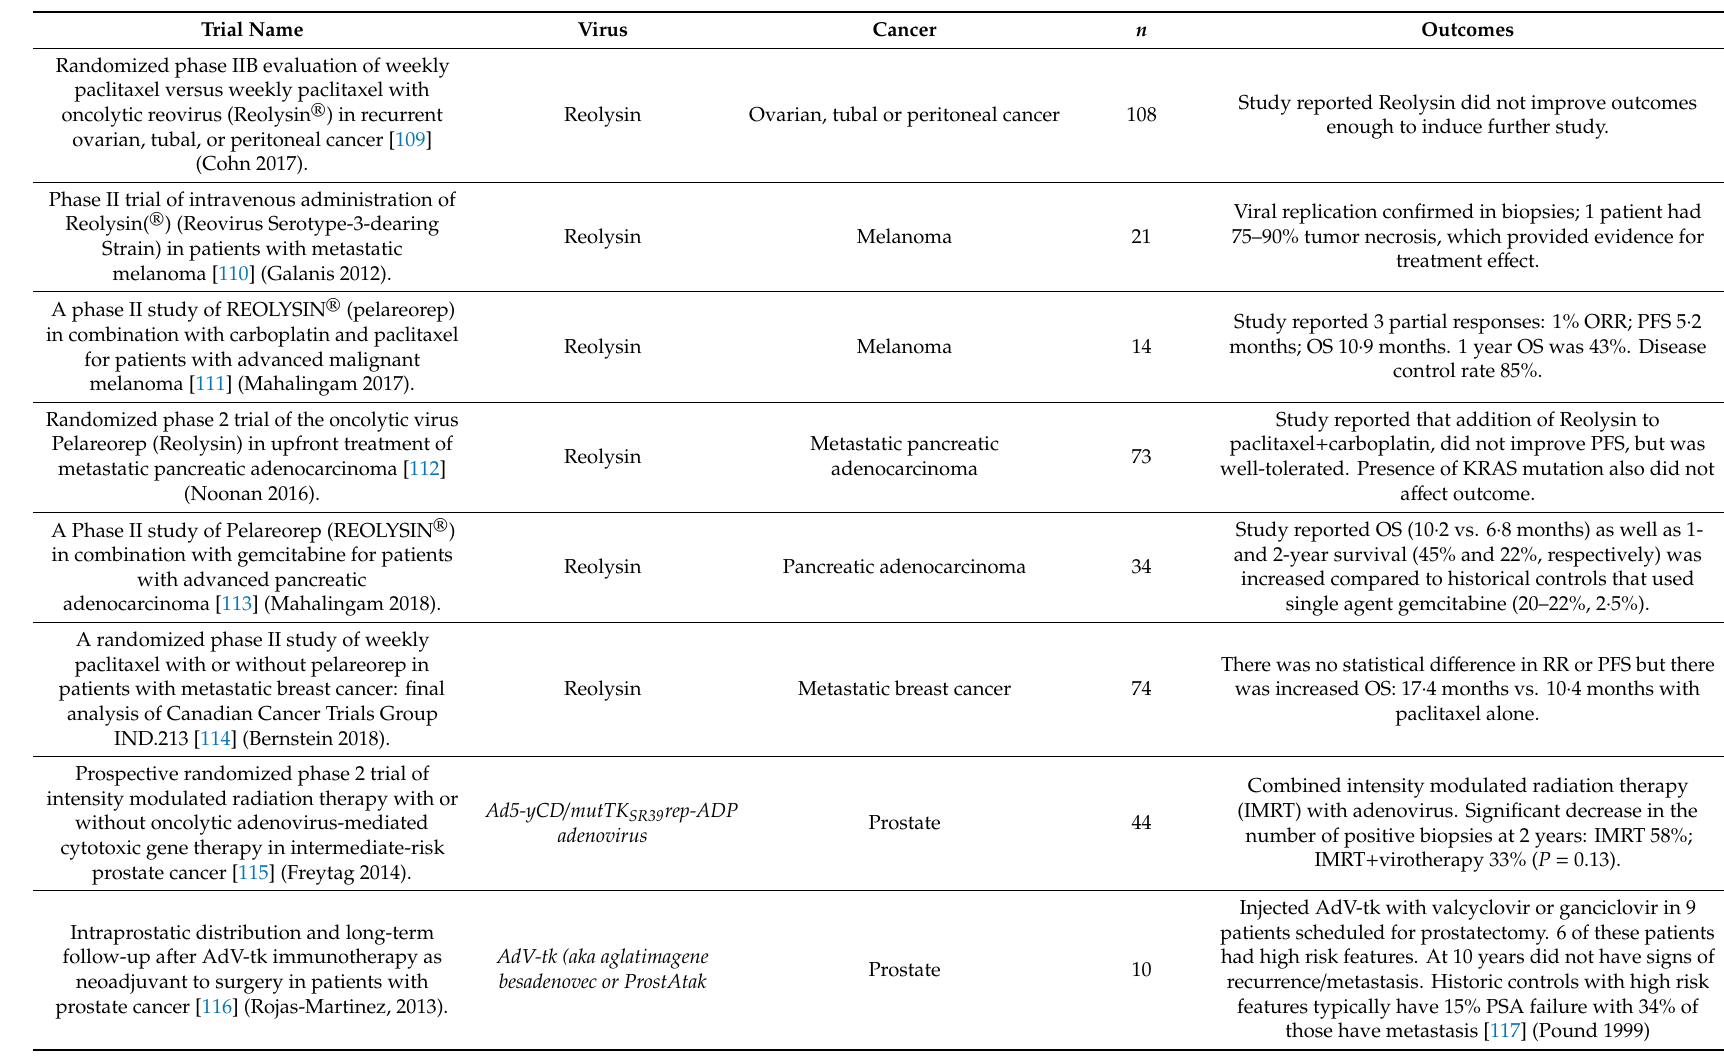
Table 3. Summary of oncolytic virus use in phase II clinical